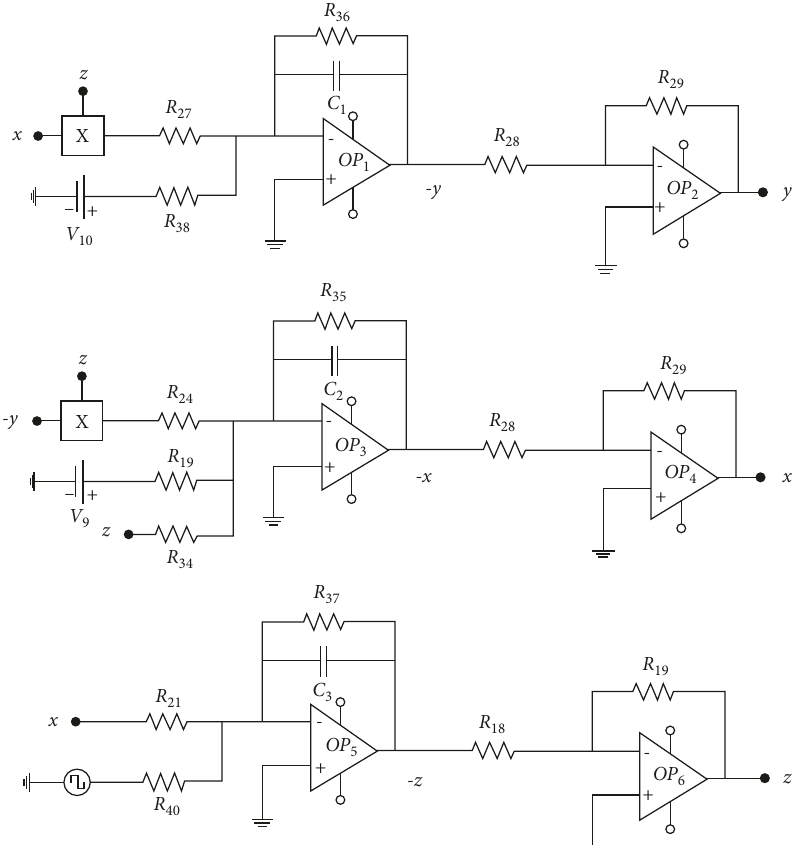
Figure 20: Electronic implement of the square load torque in this machine. The squared load torque is T